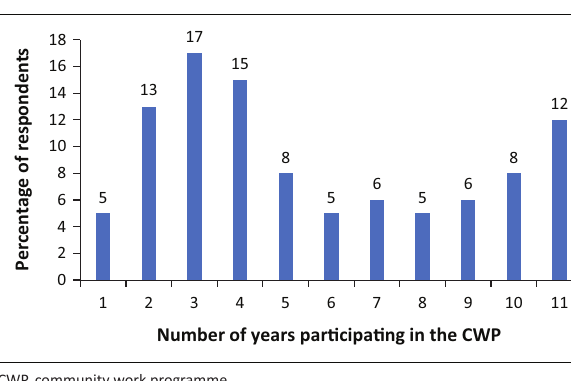
FIGURE 1: Respondents’ number of years participating in the community work